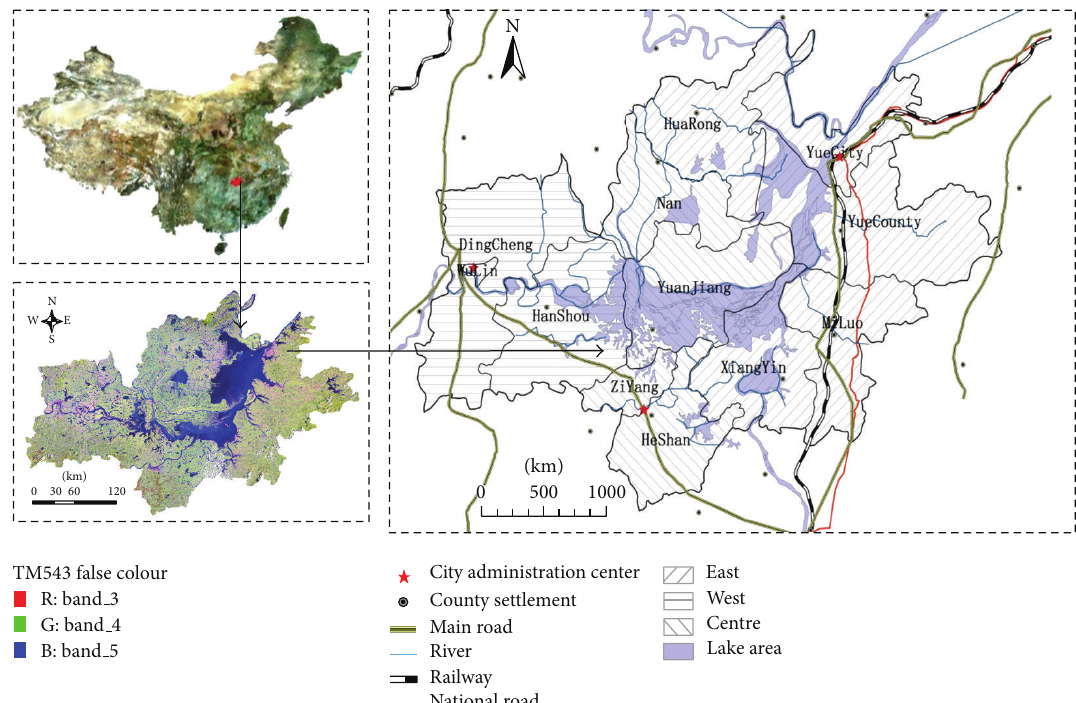
Figure 1: The location of the study